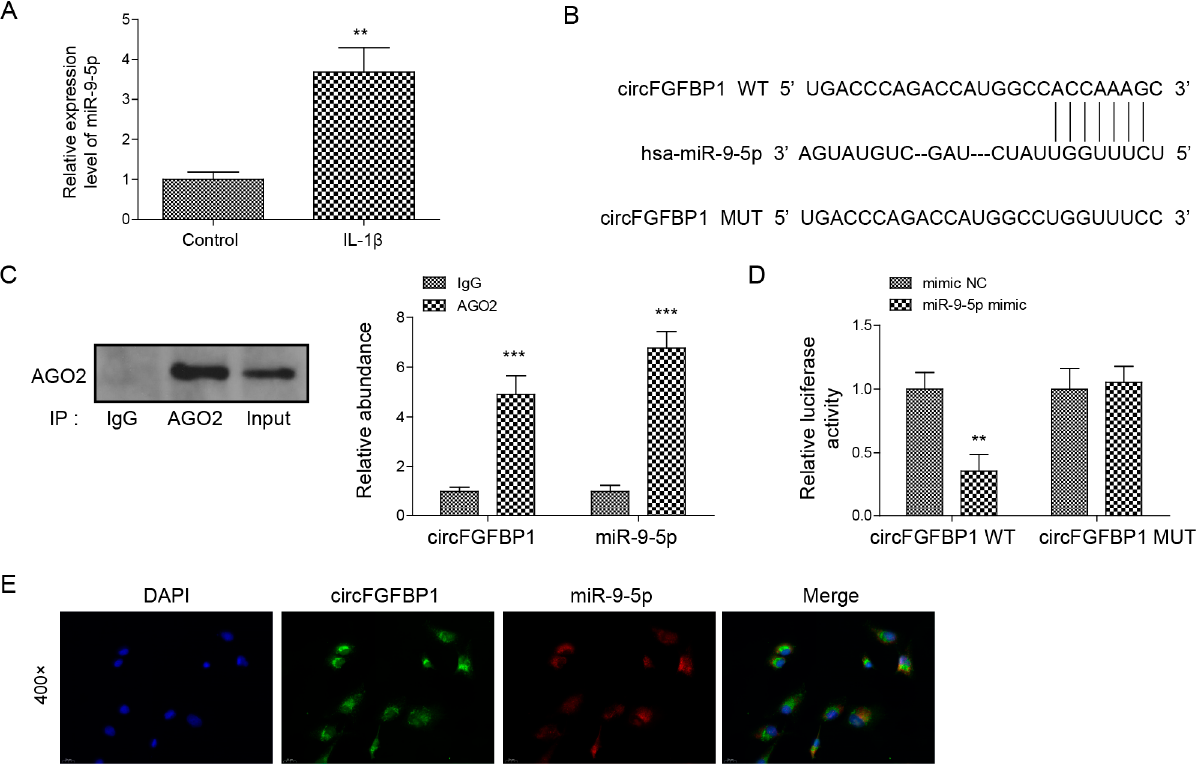
Figure 4. CircFGFBP1 serves as a miRNA sponge of miR-9-5p. ( A ) miR-9-5p expression by qPCR. ( B ) The potential site of circFGFBP1 located in miR-9-5p by starBase. ( C , D ) The relationship between circFGFBP1 and miR-9-5p via RIP-qPCR ( C ) and dual luciferase reporter gene assay ( D ). ( E ) The colocalization of circFGFBP1 and miR-9-5p by FISH. Data were estimated as mean ± SD. ** p < 0.01, *** p < 0.001.